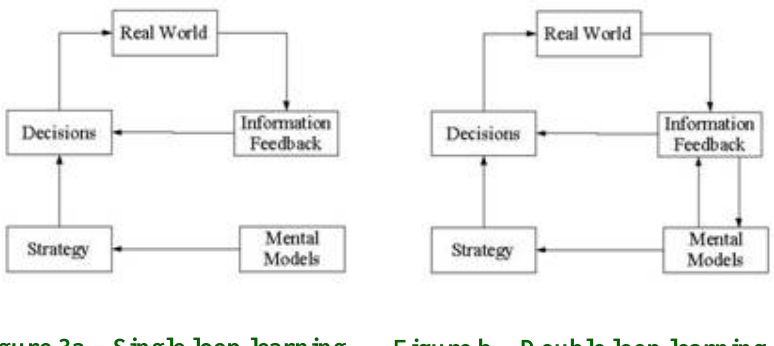
Figure 3a – Single loop learning Figure b – Double loop